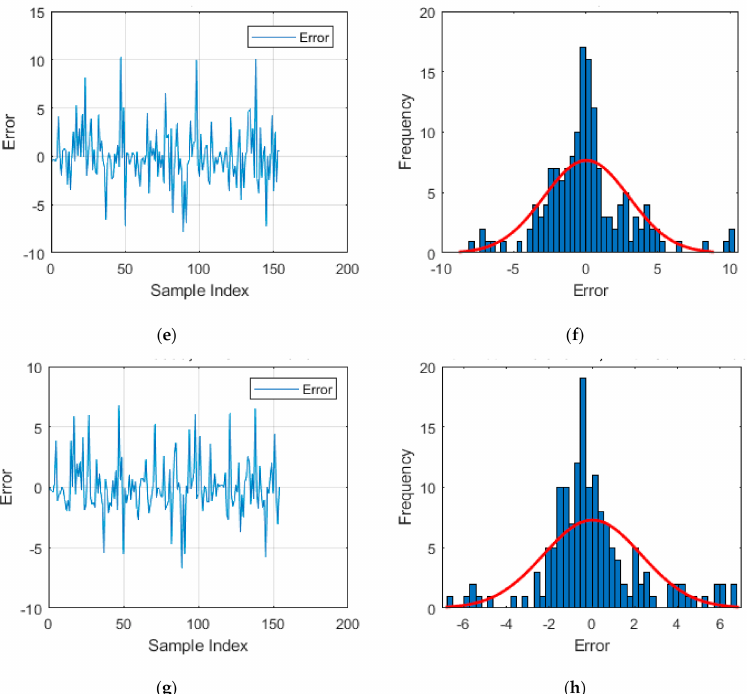
Figure 7. Direct errors and their frequency drawn for the testing results of ( a , b ) MLPNN, ( c , d )